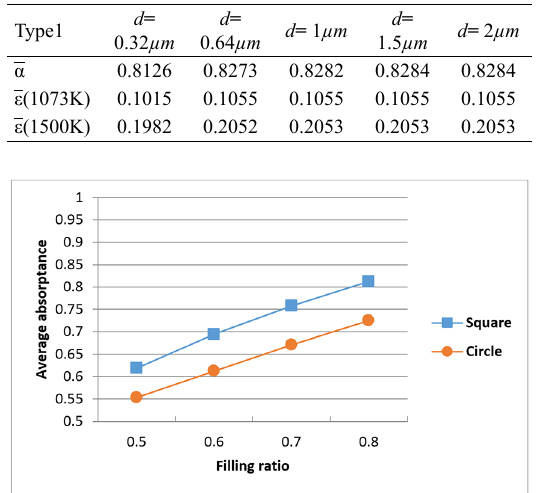
Table 2. The average absorptance and emittance of type 1